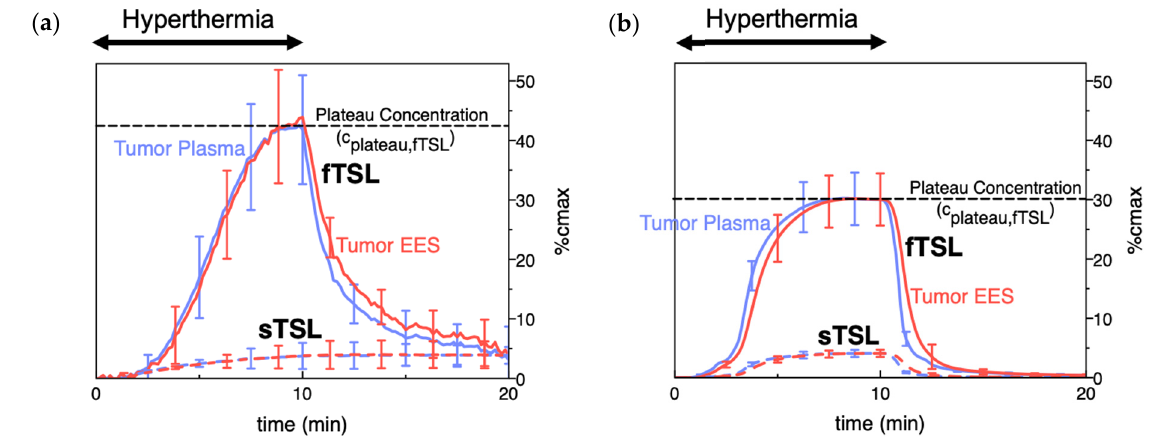
Figure 8. TSL delivery kinetics. ( a ) Drug concentration in plasma and interstitium (extracellular- extravascular space, EES) was determined from intravital microscopy data. Hyperthermia (42 ◦ C) for 10 min was applied following the administration of either slow- (sTSL) or fast-release TSL (fTSL) encapsulating a fluorescent drug analog (carboxyfluorescein) (see Figure 7 for release kinetics of sTSL and fTSL). Plasma concentration increases during hyperthermia due to drug release. Re- leased drug is then extracted by tissue, indicated by increasing interstitial (EES) concentration. A plateau (peak) concentration is approached towards the end of hyperthermia. This plateau concen- tration is substantially higher for fTSL compared to sTSL. Error bars indicate standard deviation (n = 3 animals/group). ( b ) Computer simulation of drug delivery kinetics based on in vivo measured tumor properties reproduces the delivery kinetics observed in ( a ). Error bars indicate computer model uncertainty due to uncertainty of model parameters. Figures reproduced from [20] (published under CC BY 4.0